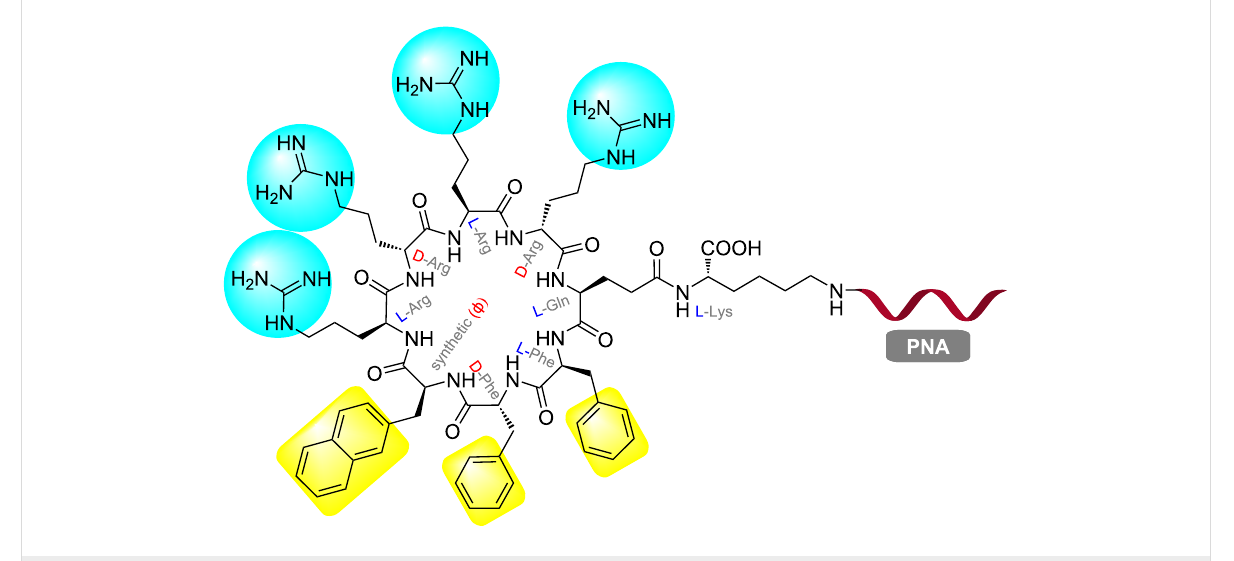
Figure 15: Chemical structure of C 9 –PNA, a stable amphipathic (cyclic-peptide)–PNA conjugate.